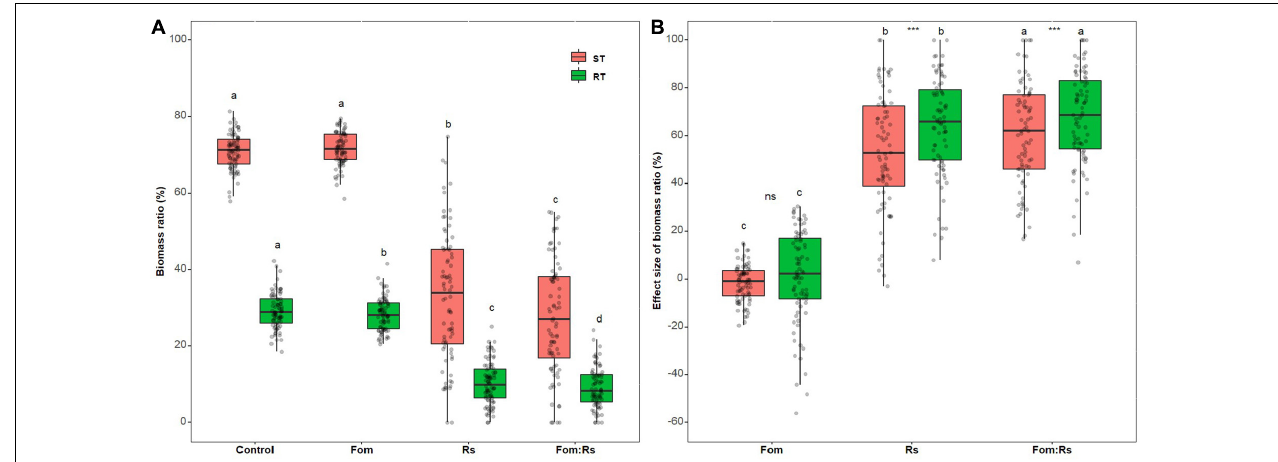
FIGURE 3 | Pathogen effects on biomass allocations among 80 alfalfa varieties single or co-inoculated with Fom and Rs. (A) Variations in shoot biomass ratio (ST) and root biomass ratio (RT) and (B) effect sizes of ST and RT. Fom, single inoculation with Fom; Rs, single inoculation with Rs; Fom:Rs, co-inoculation with Fom and Rs. Boxplots show the medians and 25th and 75th percentiles, with whiskers extending to 1.5 times of the interquartile range, and data presented beyond whiskers represent outliers. Different letters above the bars in the same column indicate significant differences ( p < 0.001) among treatments according to Fisher’s protected LSD test. Asterisks between the bars under the same treatment indicate a significant difference ( p < 0.001) between traits by Student’s t -test. ns, not significant between